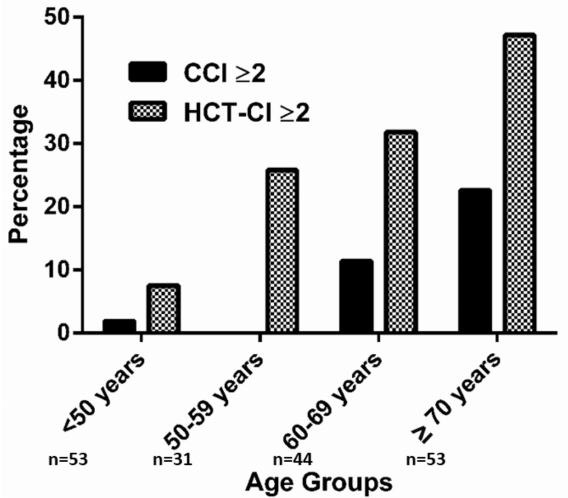
Figure 1. Prevalence of HCT-CI and CCI ≥ 2 according to age groups. Prevalence rates according to age groups: < 50 years: CCI ≥ 2, 1.9% HCT-CI ≥ 2, 7.5%; 50–59 years: CCI ≥ 2, - HCT-CI ≥ 2, 25.8%;